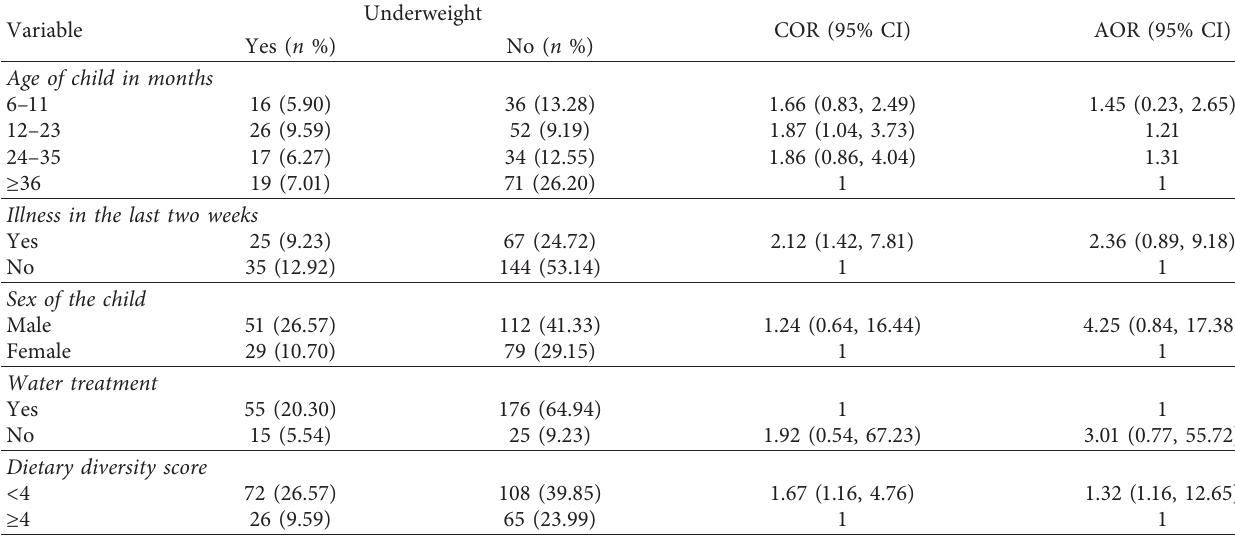
Table 6: Factors associated with underweight among orphan under-five children in Addis Ababa, Ethiopia, 2020 ( n � 271).